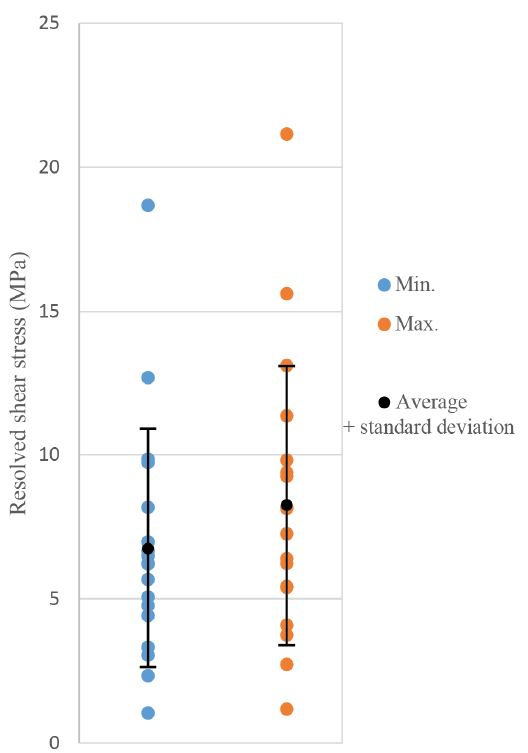
Figure 27. Graph showing the relationship between the Schmid factor obtained after inversion of the twin data using CSIT2 and the range of global stresses at the time of twin appearance. The twinned planes with a negative Schmid factor have been removed. From the photographs taken throughout the experiment it is possible to determine a resolved shear stress for which the appearance of the twin plane can be seen. Thus, a twin appearing in a photo x appeared in the interval [x − 1; x]. In fact, the previous photo did not yet show a twin plane. Thus, the minimum value approximated in this graph corresponds to the resolved shear stress calculated for x − 1. The maximum value corresponds to that for step x.